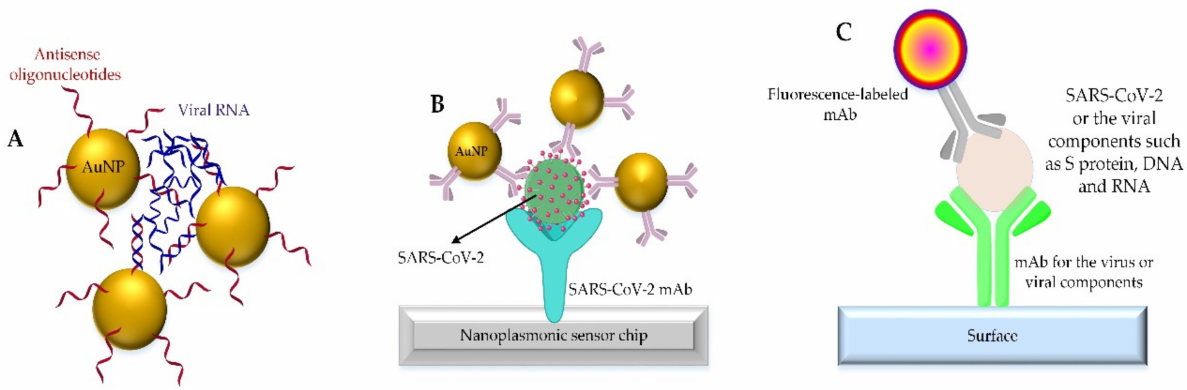
Figure 7. Different strategies used for the detection of SARS-CoV-2 by nanoparticles ( A , B ) and/or fluorescently labeled nanoparticles ( C